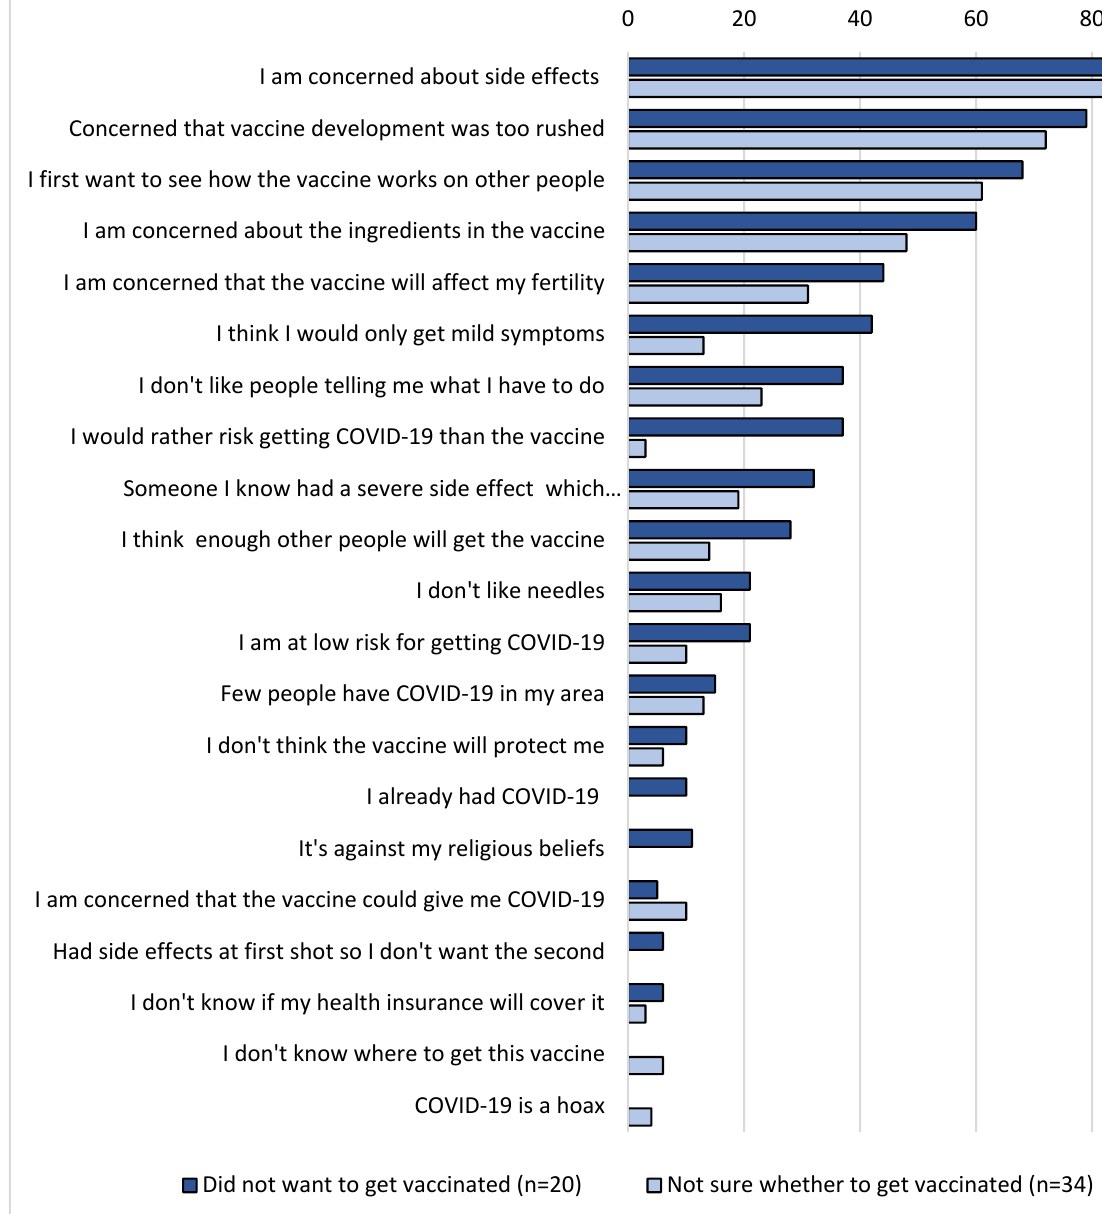
Figure 2. Agreement (rated as somewhat or strongly) with reasons against getting vaccinated among those who did not want to get vaccinated against COVID-19 ( n = 20) and those who were not sure whether to get vaccinated ( n = 34). (COVID-PCD study, May 2021).